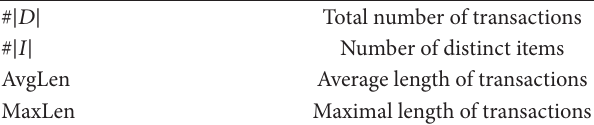
Table 6: Parameter